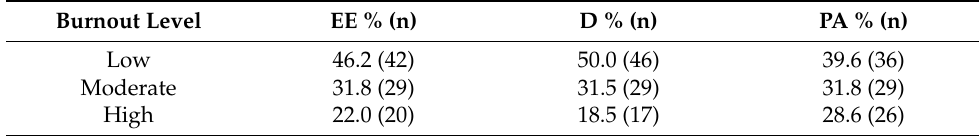
Table 3. Categorisation of levels of burnout by